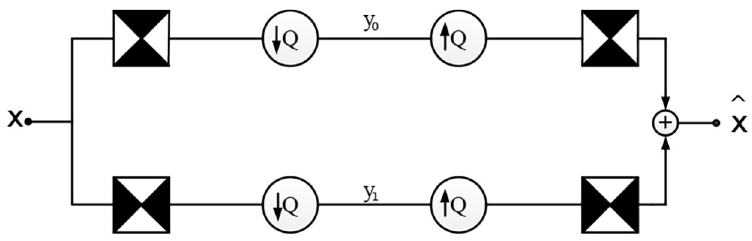
Fig 2. A 2-D spectrum partitioning using quincunx filter banks with fan